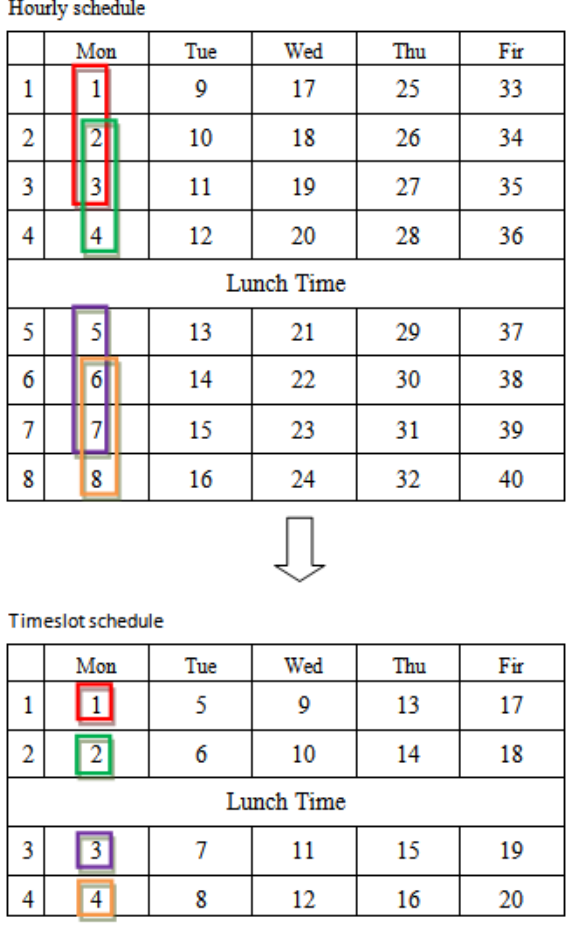
Figure 1. Representation of timeslots for course